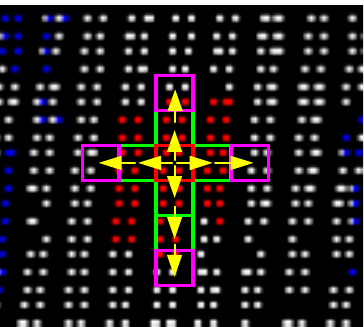
Figure 8. Search path in four directions.